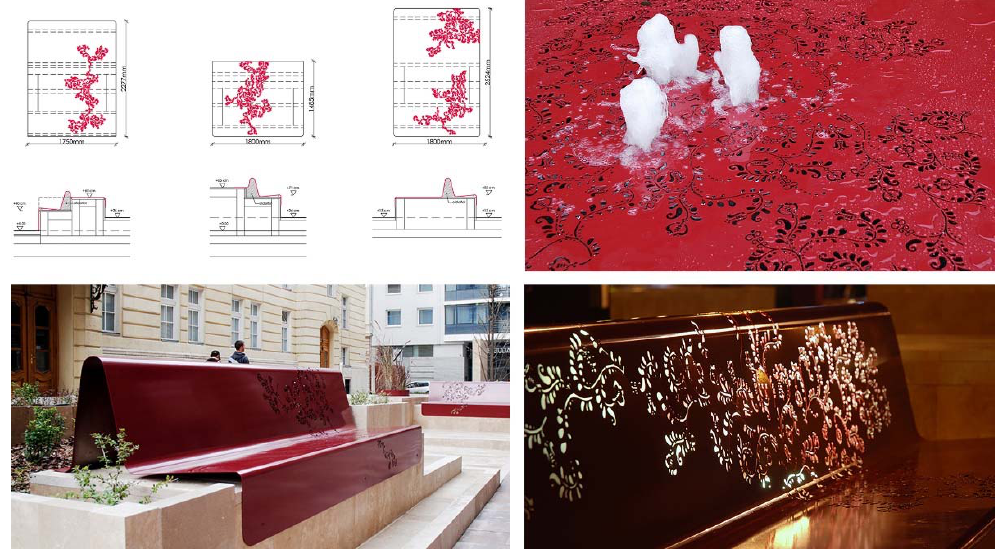
Figure 7. Design detail plans and realised elements of the unique street furniture in the Ditrói Mór street, Budapest. The unique street furniture with innovative design has multiple roles: serving as benches, and also for water features and lighting. The red steel provides a strong contrast to the white limestone slabs that are usual at Budapest public spaces, and thus a characteristic, unique design is achieved at the promenade. (Photos by authors, 2014).